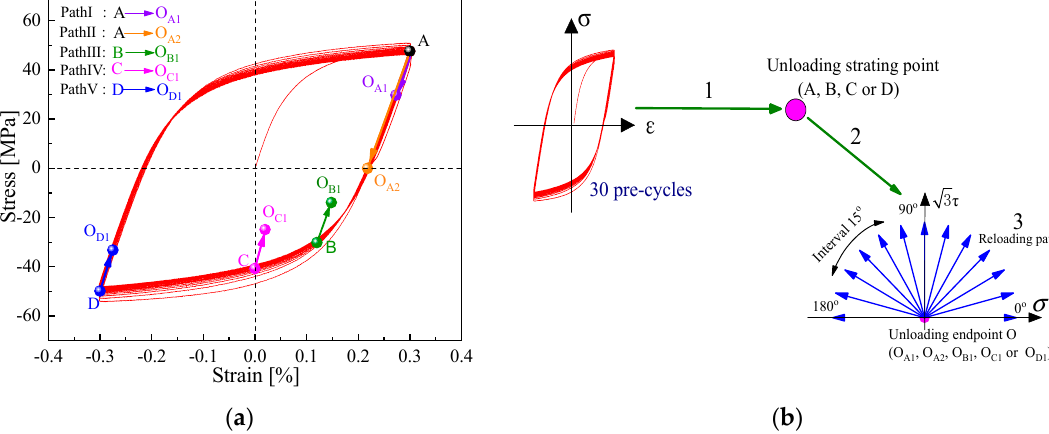
Figure 3. The probing paths of the subsequent yield surface including pre-cycle, unloading, and reloading cases: ( a ) different unloading starting points and end positions after tension-compression pre-cycle; ( b ) schematic diagram of pre-cycle, unloading, and reloading paths of yield surface.